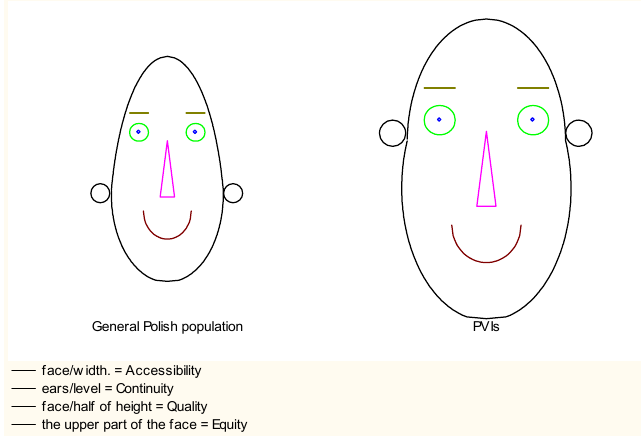
Figure 3. Visualization of expectations towards PHC in PVIs and the general population.